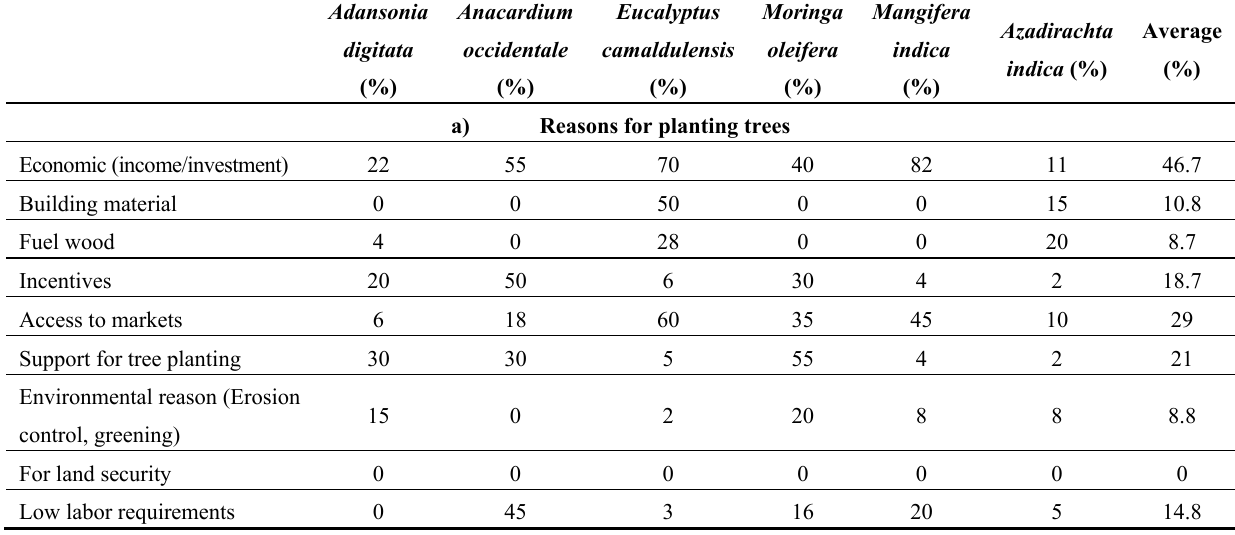
Table 4. Farmers’ reasons for (a) planting trees and (b) not planting